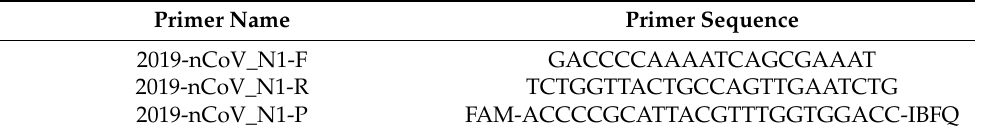
Table 1. SARS-CoV-2 qRT-PCR primer